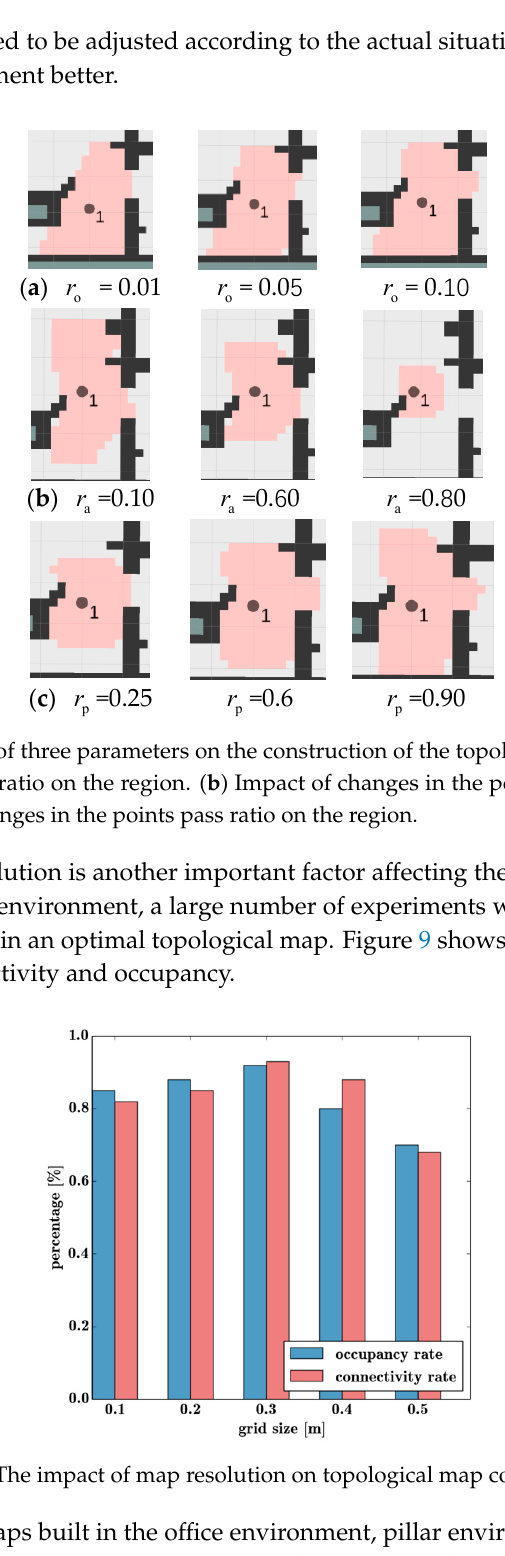
Figure 7. Occupied map ( left ) and its corresponding topological map ( right ).